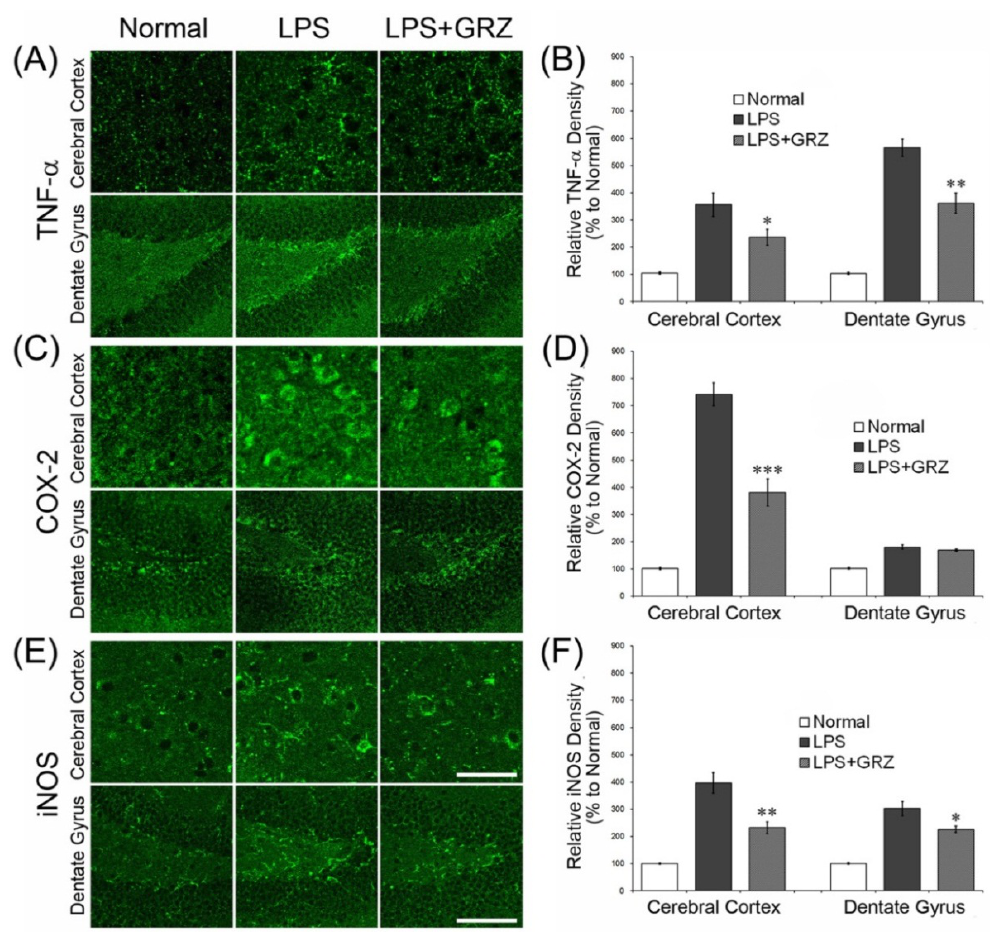
Figure 2. Effect of GRZ on TNF- α , COX-2, and iNOS expression in brain tissue immunohistochemistry. Representative TNF- α -, COX-2- and iNOS-expressing cells in the brain tissue of mice which performed the Morris water maze test. Scale bars are 100 μ m ( A , C , E ) GRZ (30 mg/kg) significantly attenuated the relative immune-densities of TNF- α (B) COX-2 ( D ) and iNOS; and ( F ) in the cerebral cortex or in the dentate gyrus of hippocampus. Data are represented by mean ± SEM (n = 6 in each group; * p < 0.05; ** p < 0.01; *** p < 0.001 compared to the LPS